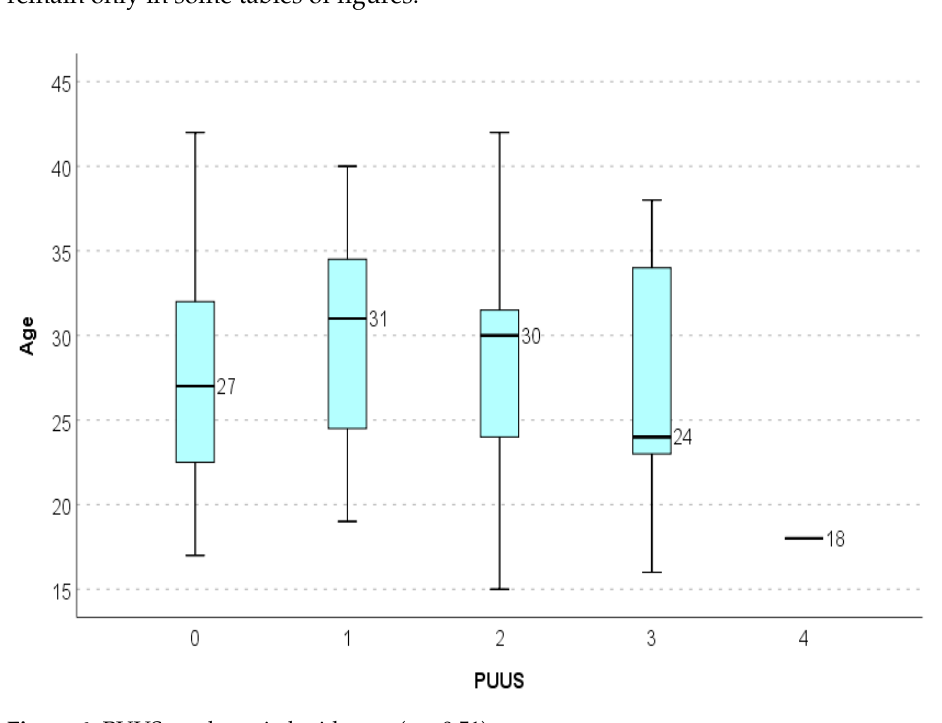
Table 2. Distribution of patients regarding the method of delivery. Method of